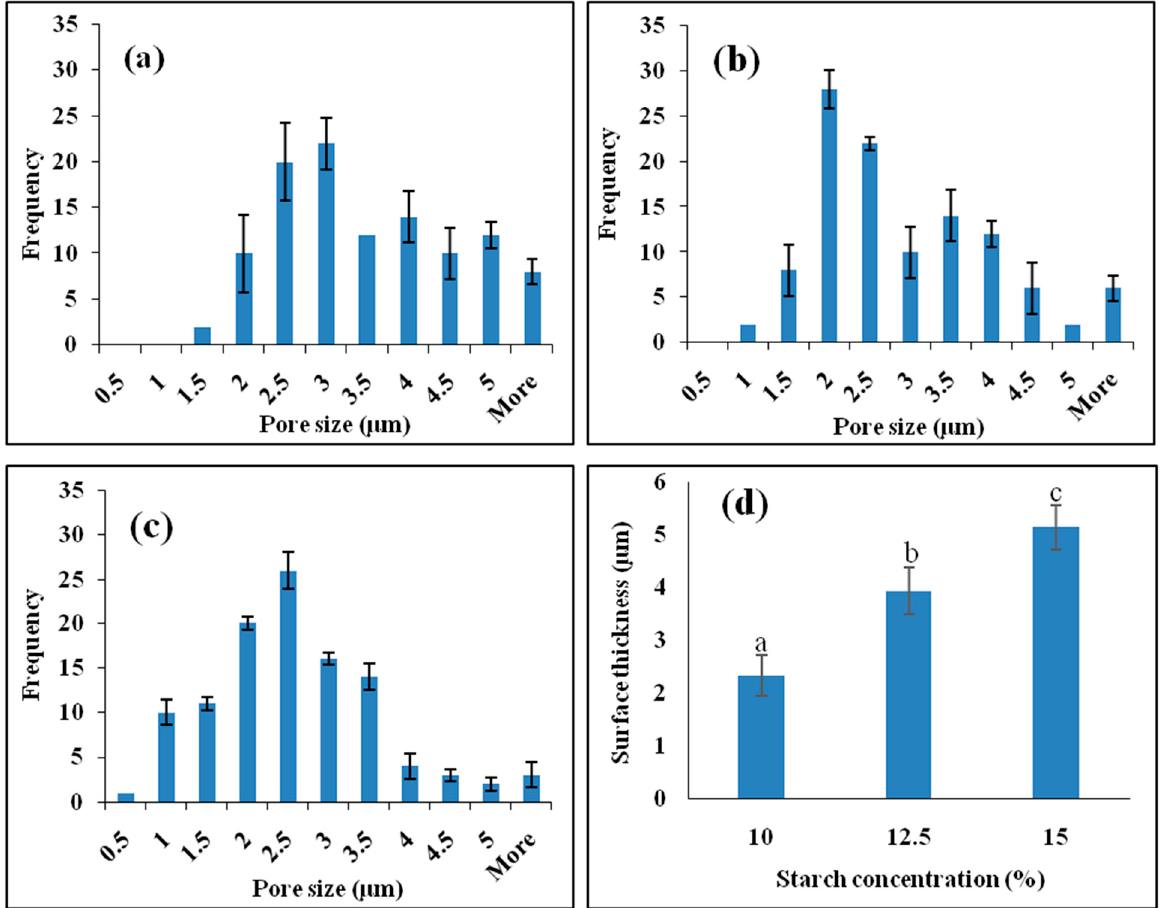
Figure 4. Pore size distribution of the 3D-printed starch beads produced using starch concentrations of ( a ) 10, ( b ) 12.5, and ( c ) 15% ( w / w ), and ( d ) their surface thickness (N = 3).